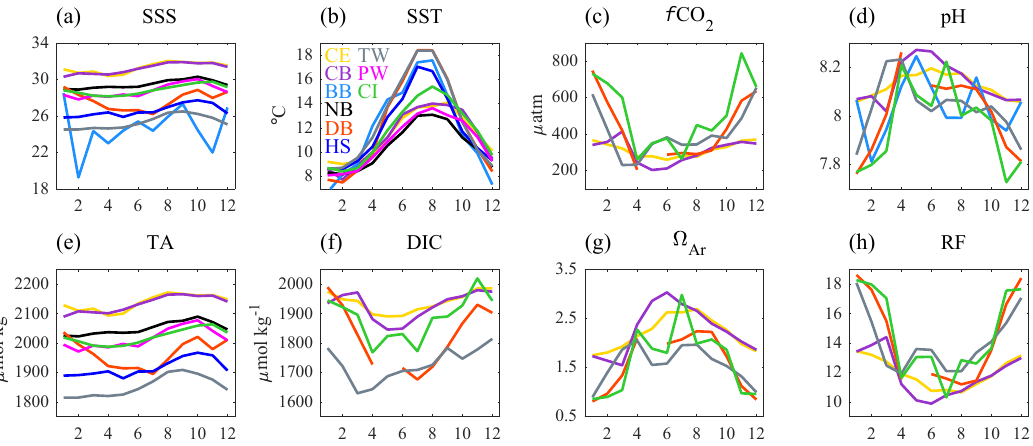
Figure 5. Near-surface ( ∼ 1m) seasonal cycles of (a) SSS, (b) SST, (c) f CO 2 , (d) pH T , (e) TA, (f) DIC, (g) (cid:127) Ar , and (h) Revelle factor (RF) for the nine moorings shown in Fig. 1a: Cape Elizabeth (CE), Chá b˘a (CB), Carr Inlet (CI), Dabob Bay (DB), Twanoh (TW), Hoodsport (HS), Point Wells (PW), North Buoy (NB), and Bellingham Bay